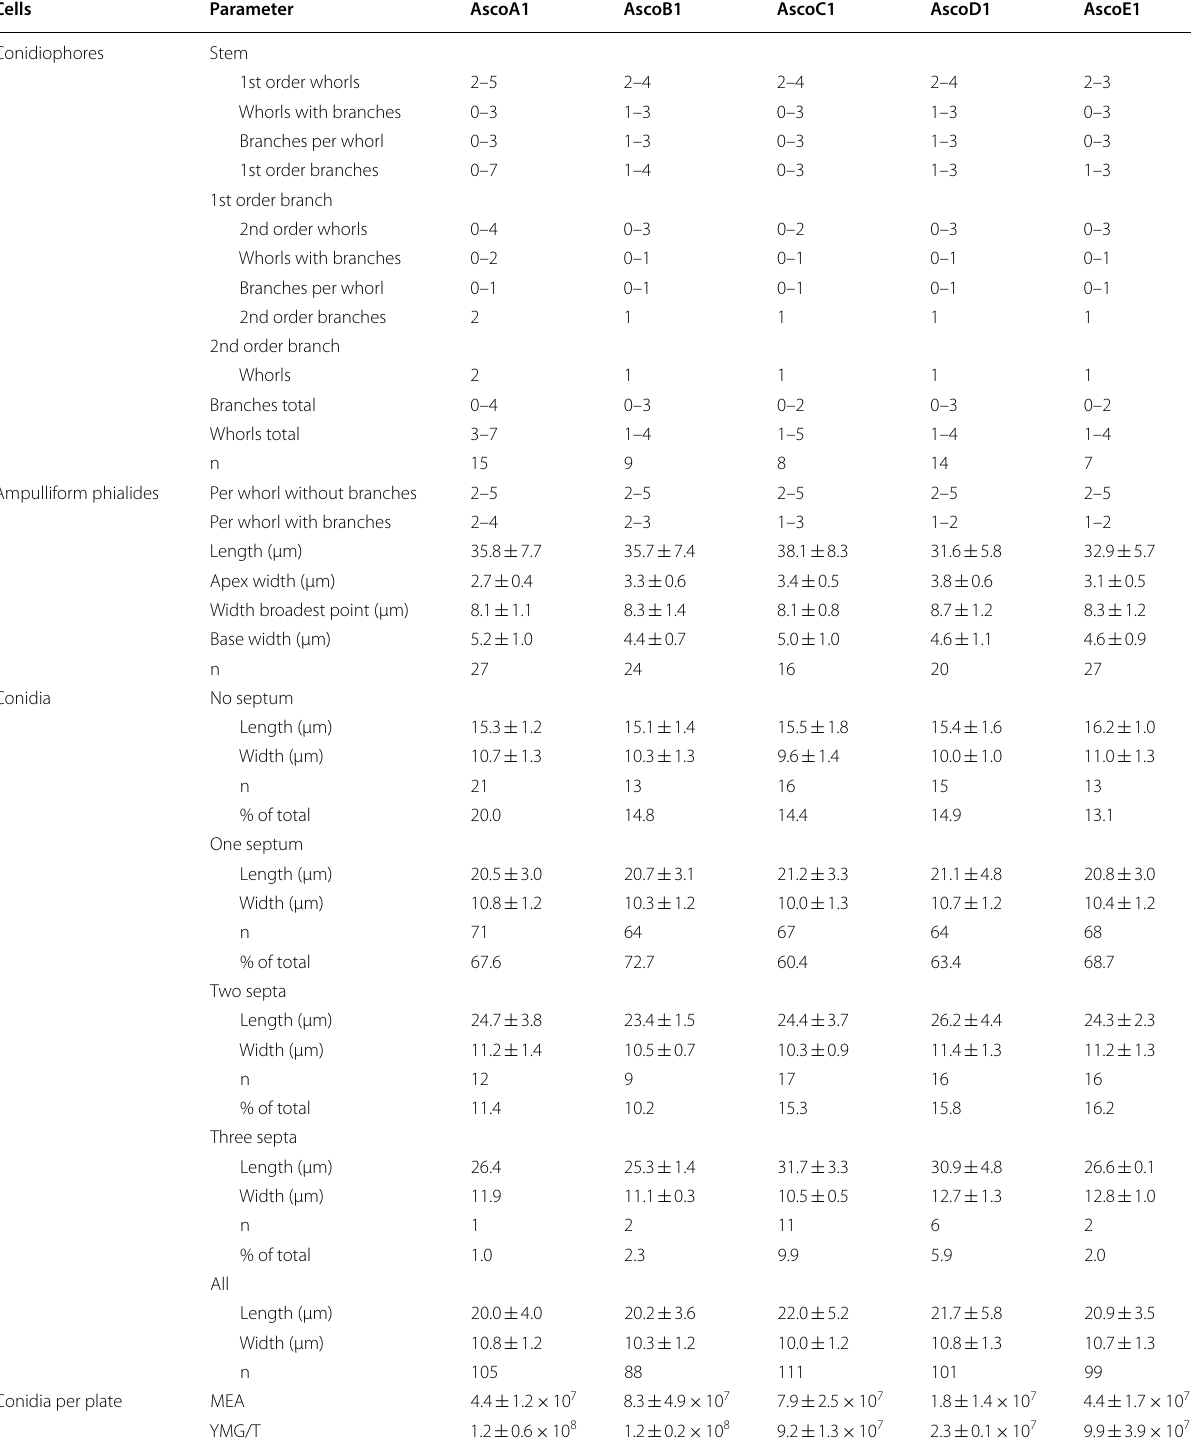
Strains were cultivated for 13 days at RT on MEA and conidiophores were taken for microscopy from the outer white growth zone characterized by flocks of conidia. n number of structures or cells analyzed. For counting spores per plate, five plates per strains and per medium were inoculated and spores were counted after fully = growth of plates at